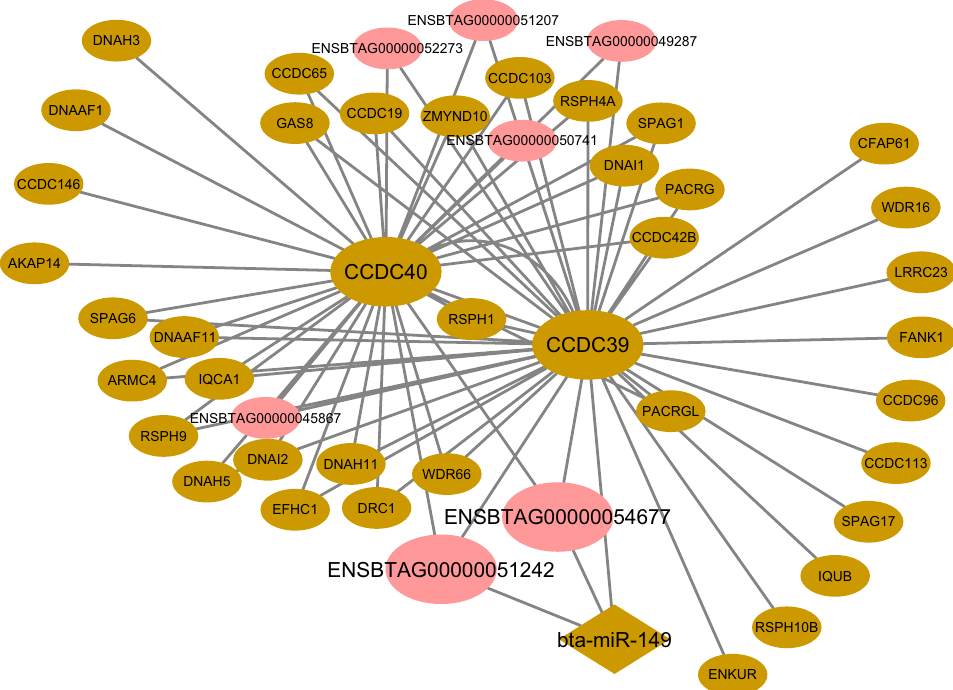
Figure 10. The constructed integrated regulatory sub-network related to CCDC40 and CCDC39 in brown Rb-module. The pink circles indicate hub and hub-hub lncRNAs. The brown diamond represents hub miRNA that be predicted to regulate CCDC39 and hub-hub target lncRNAs including ENSBTAG00000051242 and ENSBTAG00000054677 . Cytoscape software (version 3.7.2) (https:// cytos cape. org/) was used to generate this